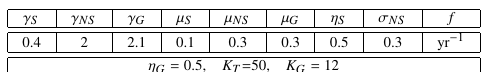
P arameters values for F igures 5 and 6